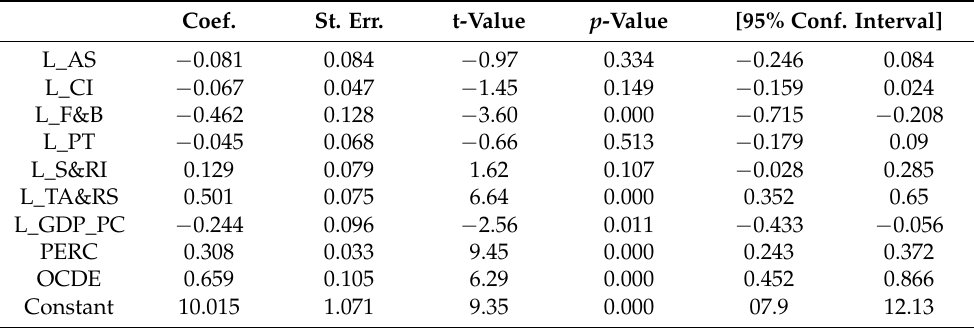
Table A4. Panel data estimations of the explanatory variables of tourism receipts (in logarithm) for the countries in the sample. OLS (pooled